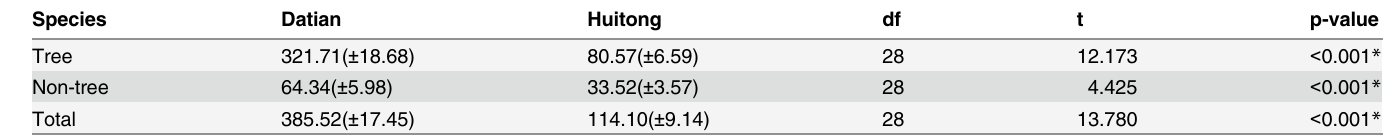
Table 6. Fine root biomass (g m -2 ) at 0 – 40 cm soil depth between sites (mean ± SE). Species Tree